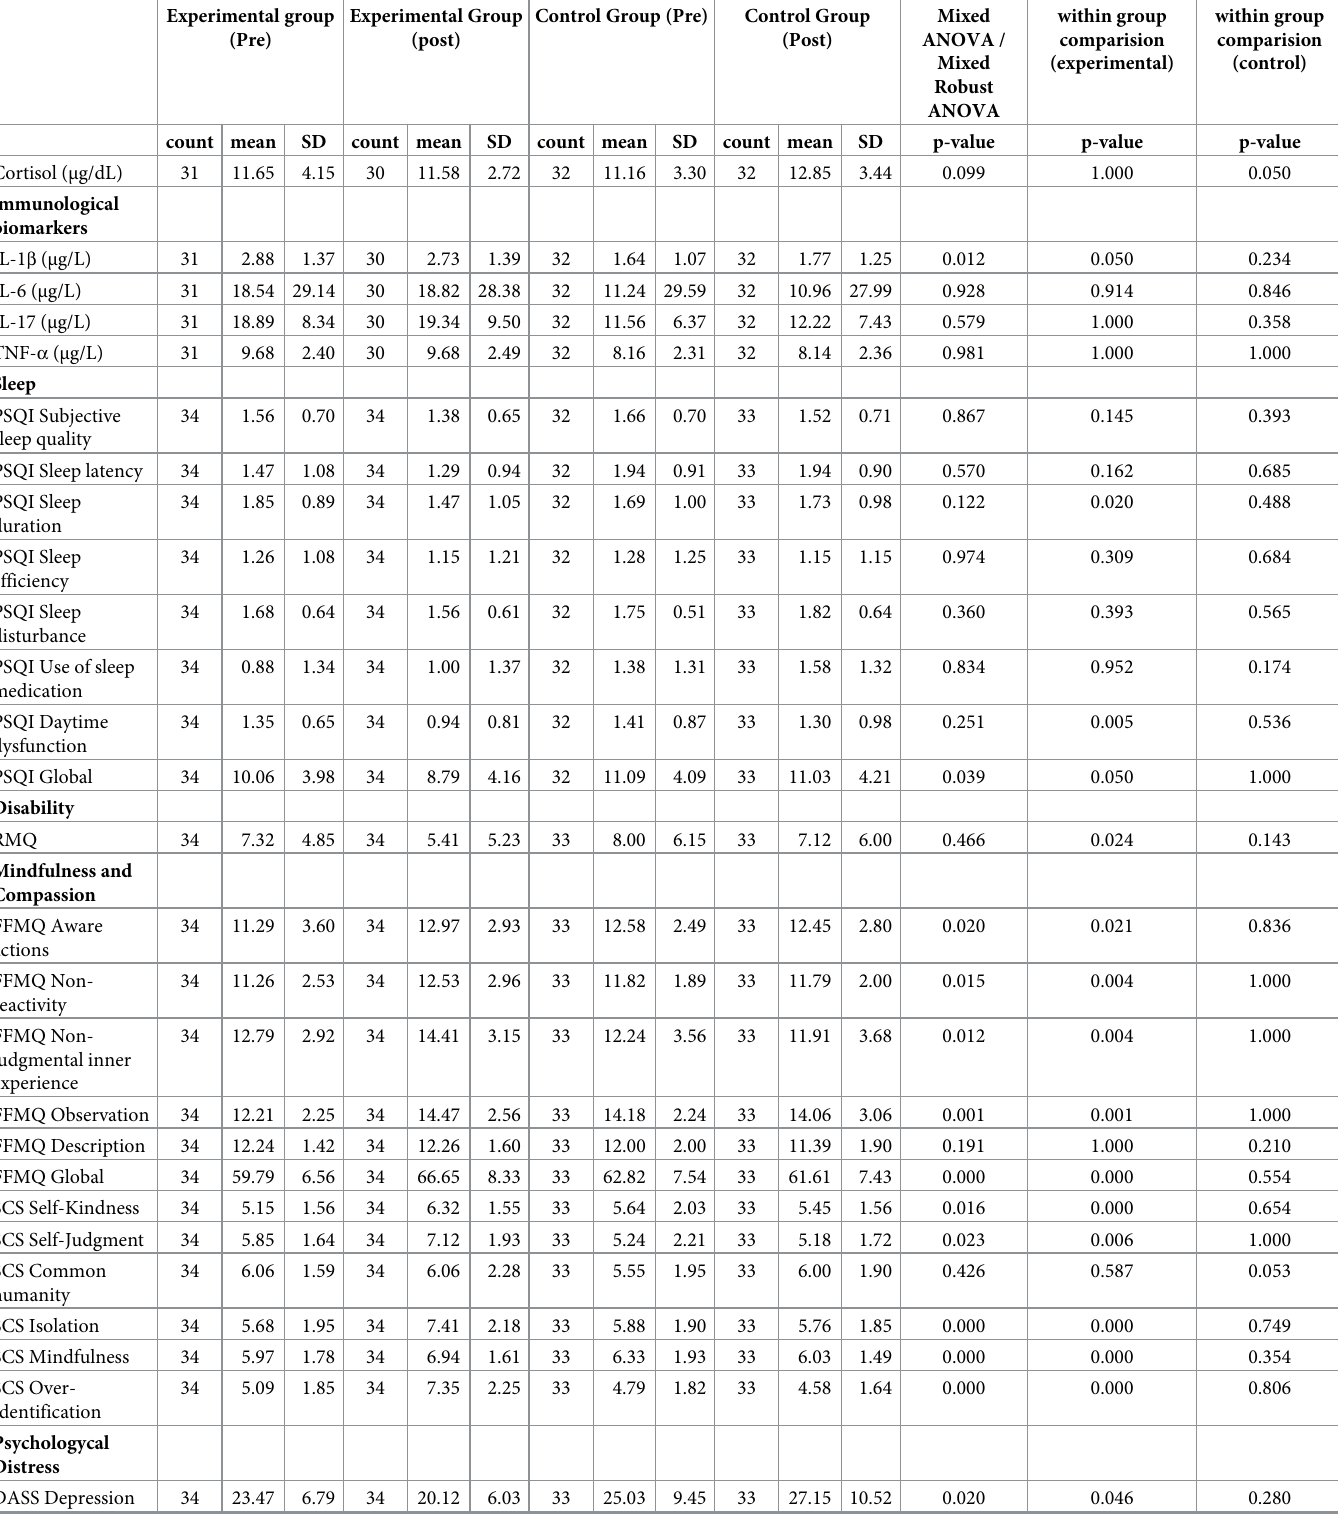
Table 1. The results of the assessment of blood biomarkers, sleep, disability, mindfulness and compassion, and psychological distress. Experimental group